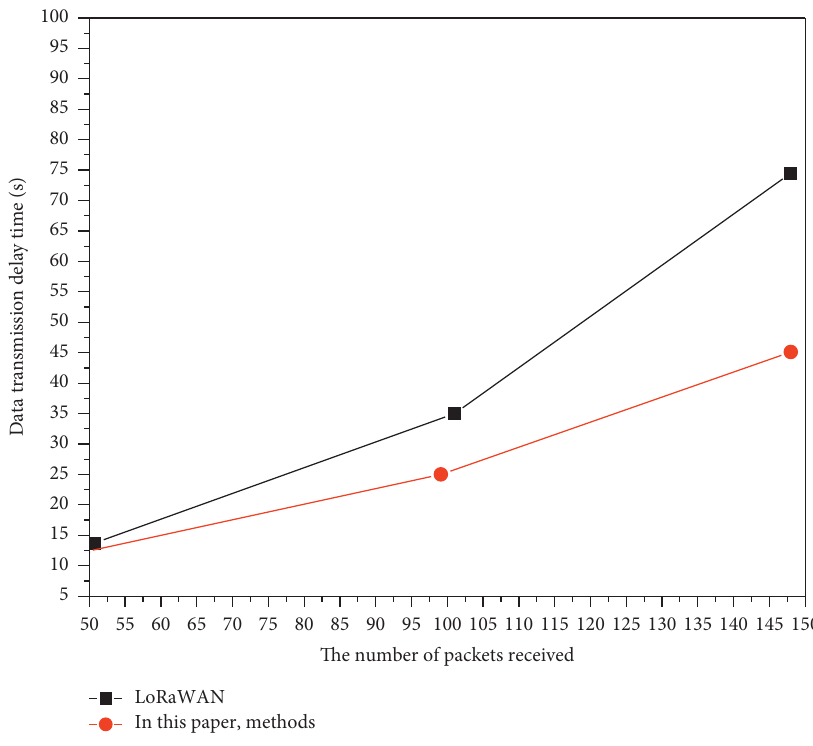
Figure 7: Comparison of transmission delay according to the number of received